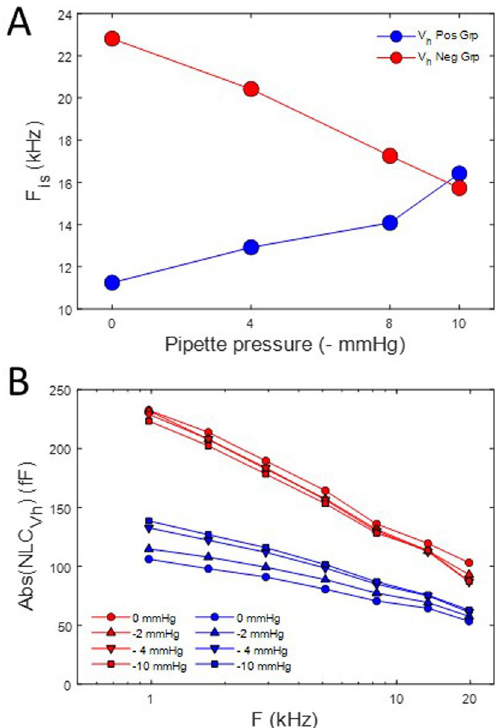
Figure 11. Summary of initial V h influence on tension effects. (A) The direction of change in F is is dependent on initial V h . Analyses were made with stray capacitance removal using either the + 160 mV (circles) or − 160 mV (asterisks) holding admittance. Results are identical, as expected. The two initial V h group responses converge until a common F is vs. tension is reached at − 10 mmHg, namely about 16 kHz. (B) Plot of the absolute magnitude of NLC for the two initial